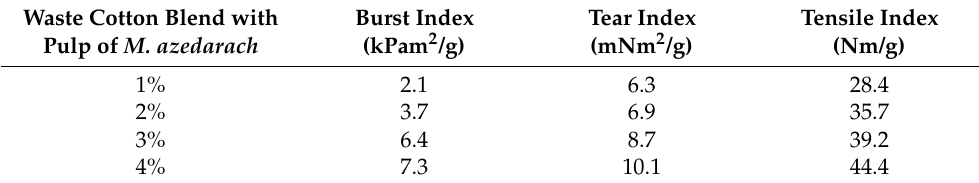
Table 6. Physical strength of M. azedarach sheets blended with waste cotton. Waste Cotton Blend